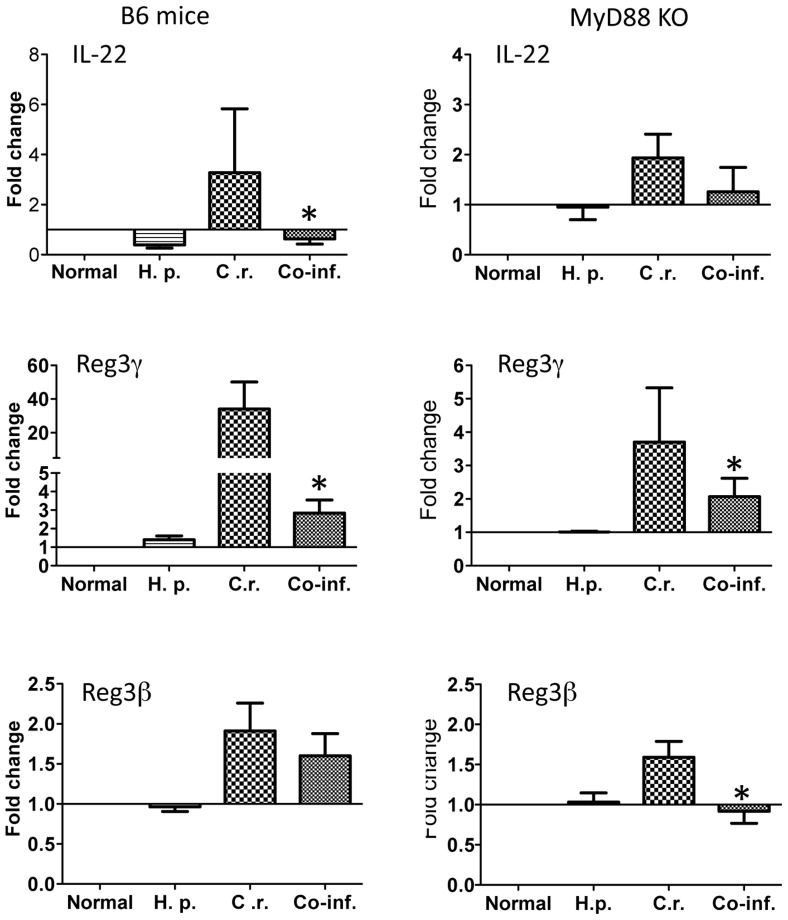
Co-infection with H. polygyrus results in down-regulation of C. rodentium-induced colonic anti-microbial peptide expression.Colon tissues were collected from control, C. rodentium-infected, H. polygyrus infected, and co-infected MyD88 knockout and wild-type mice. Total RNA was isolated. IL-22, Reg3γ and Reg3β expression was determined using quantitative RT-PCR. Values are the fold increase compared with baseline obtained from uninfected mice. The data shown are the mean ± the SEM (n = 3–5 mice/group) from one of three experiments performed showing similar results. *p<0.05.